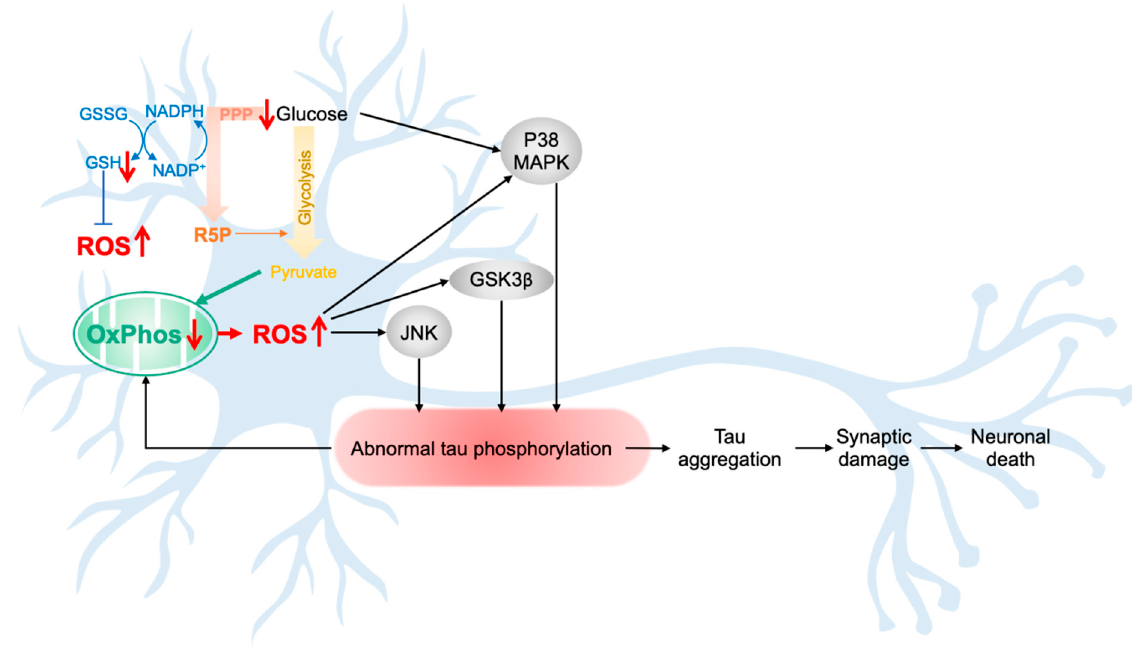
Figure 2. Potential impact of brain bioenergetic defects on tau pathology. Aging is associated with a decrease in brain glucose metabolism, impairments in mitochondrial function, namely decrease in mitochondrial oxidative phosphorylation activity (OxPhos) and increase in oxidative stress. Of note, the increase in reactive oxygen species (ROS) level in aging was linked to a decrease of brain antioxidant defenses and mitochondrial dysfunction, but might also be due to the decrease in glucose metabolism via the pentose phosphate pathway (PPP) in neurons, which is an important pathway involved in the generation of oxidized glutathione, a key regulator of reduction/oxidation state in neurons. The decrease in glucose/increase of ROS were shown to activate the tau-targeting kinases, P38 mitogen-activated protein kinase (P38 MAPK), glycogen synthase kinase-3 β (GSK3 β ), and c-Jun N-terminal kinase (JNK), triggering abnormal tau hyperphosphorylation and aggregation. Abnormal tau was shown to induce synaptic damage and neuronal death, but also to impair mitochondrial function, which may exacerbate tau pathology. Abbreviations: GSH/GSSG, oxidized/reduced glutathione; NADP+/NADPH: oxidized/reduced nicotinamide adenine dinucleotide phosphate; R5P, ribulose-5-phosphate; red arrows: ↑ increase/ ↓ decrease.